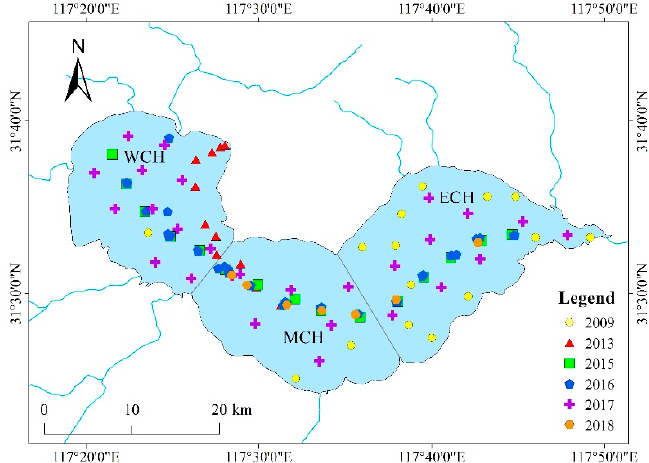
Figure 1. The study area and samples in Lake Chaohu, China, during 11 cruise surveys from October 2009 to July